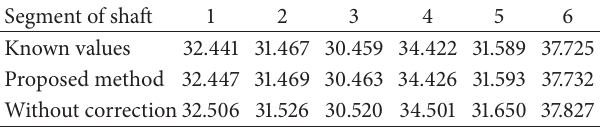
Table 2: Measurement results of segments of shaft (mm). Segment of shaft